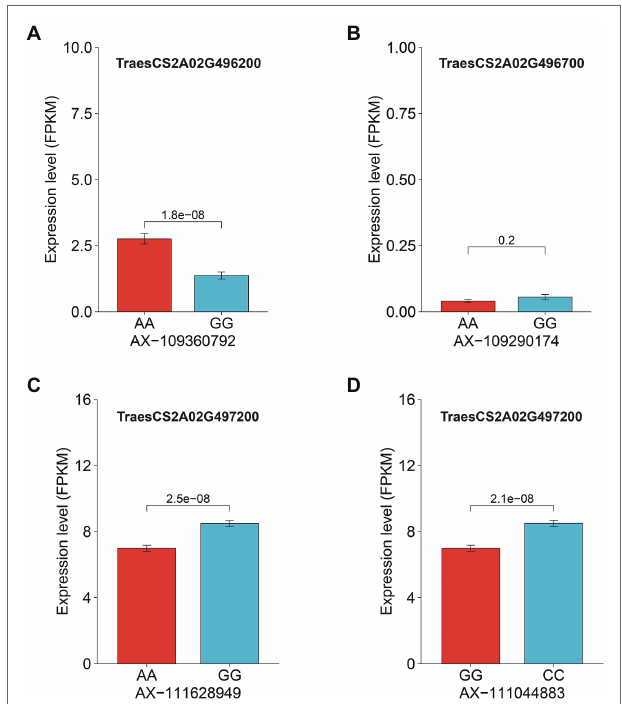
FIGURE 4 | The average expression levels of three candidate genes of wheat accessions with different genotypes of its closely associated SNPs. (A) : The expression level of TraesCS2A02G496200 between accessions with different genotypes at SNP AX-109360792; (B) : The expression level of TraesCS2A02G496700 between accessions with different genotypes at SNP AX-109290174; and (C,D) : The expression level of TraesCS2A02G497200 between accessions with different genotypes at SNPs AX-111628949 and